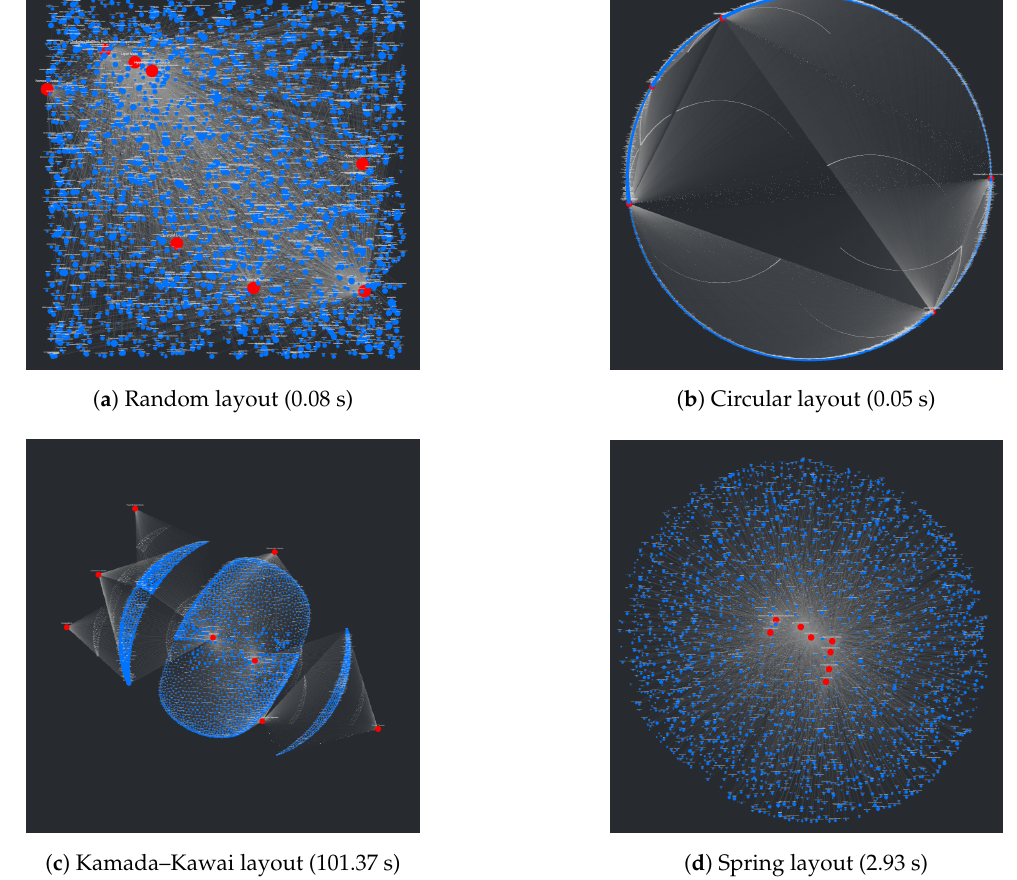
Figure 3. A sample of tested graph layouts along with their CompositeView runtimes, all based on the same SemNet results data set (approximately 2472 source nodes).